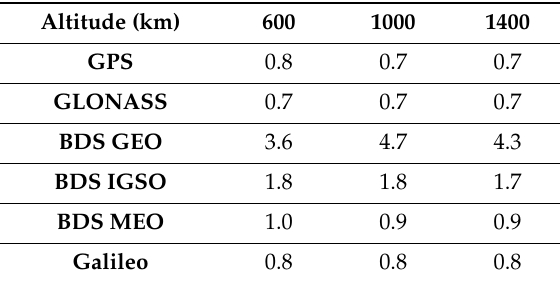
Table 5. Average 3D RMS of orbit di ff erences for the integrated POD with di ff erent altitude LEO constellations (Unit: cm). Altitude (km)